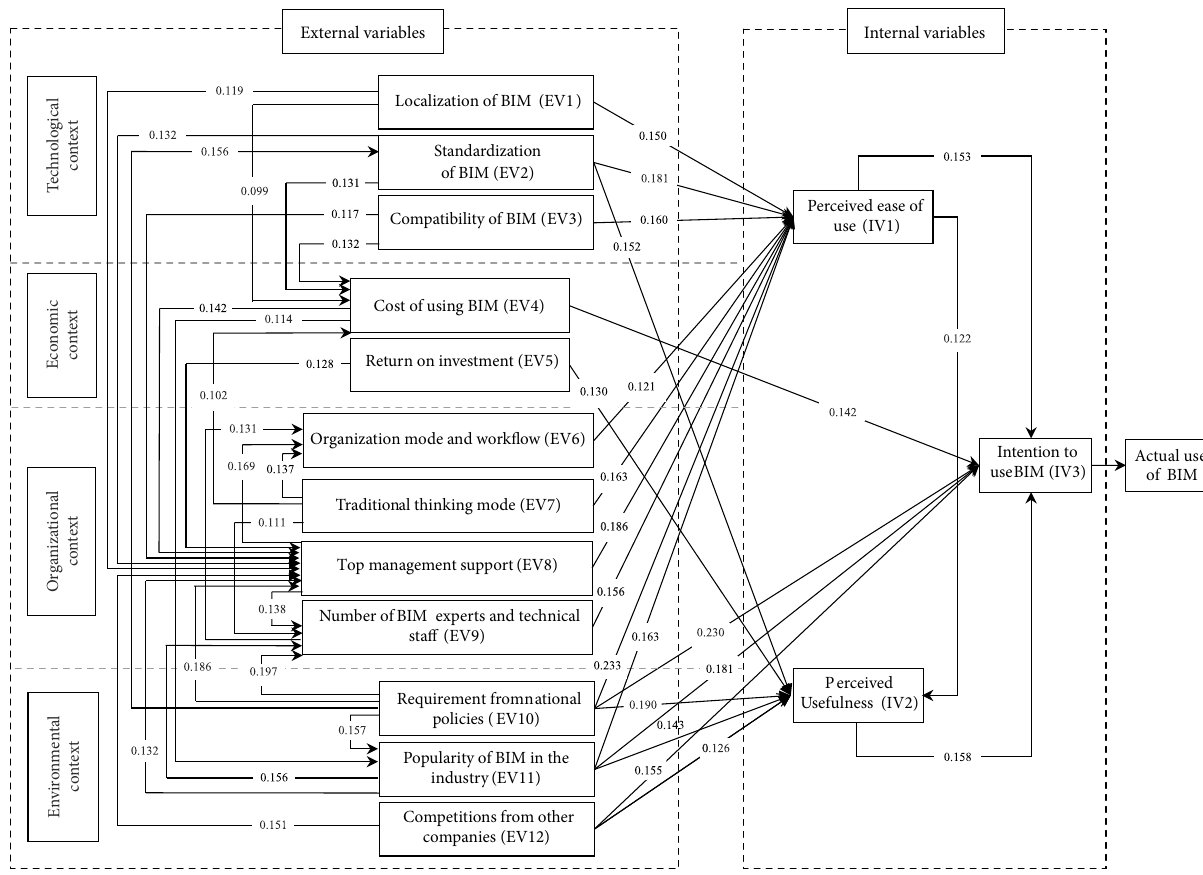
Figure 5. BIM Technology Acceptance Model based on